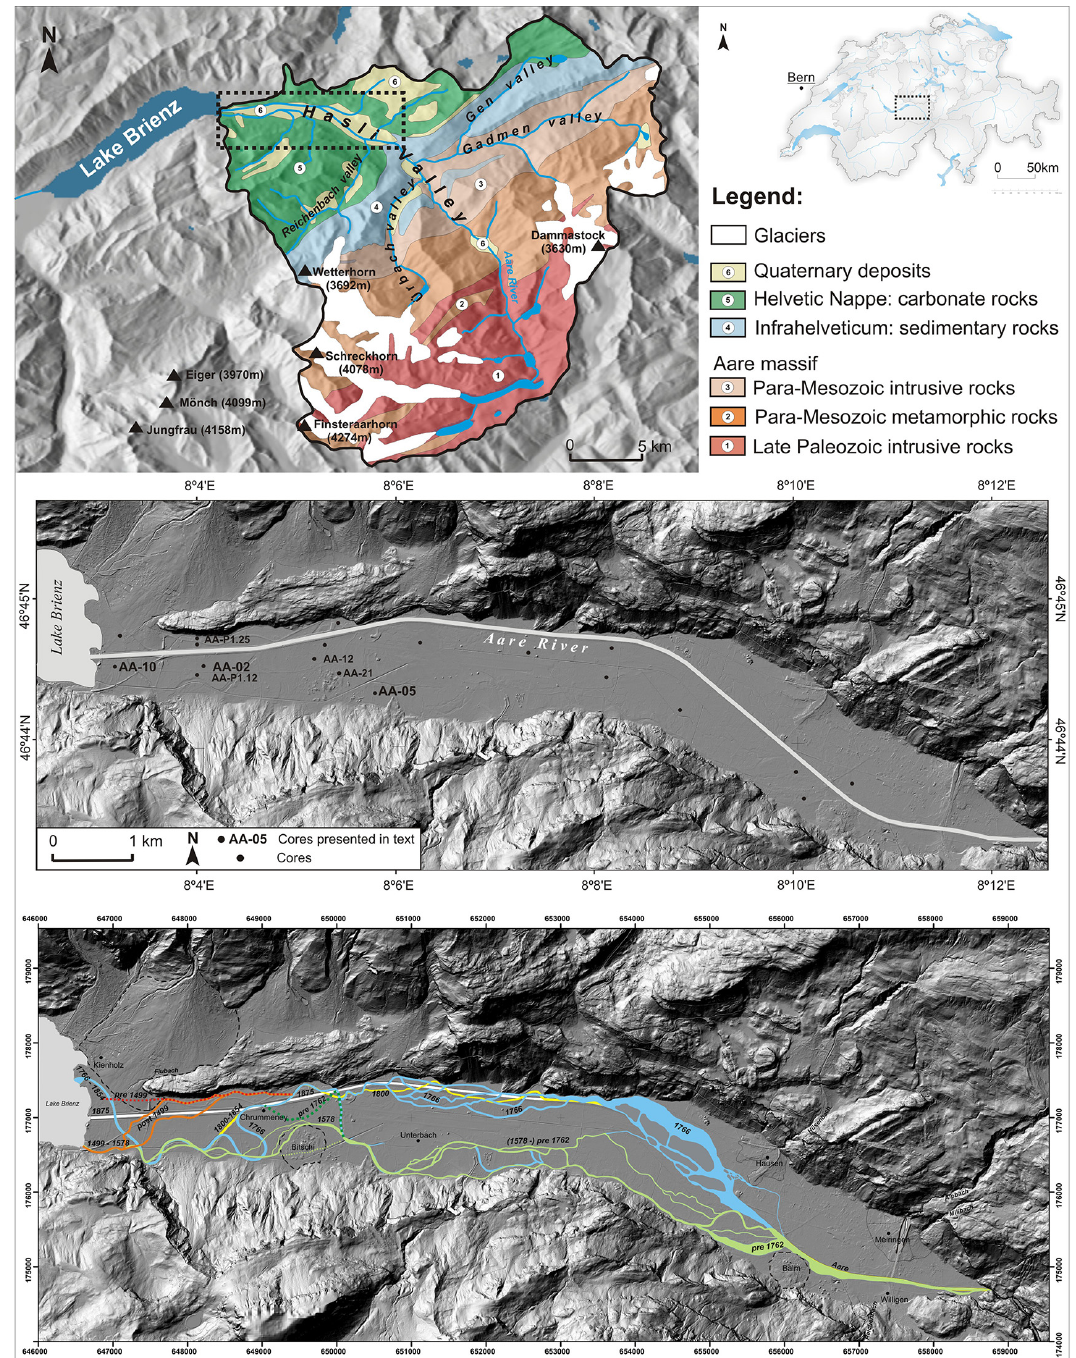
Figure 1. Geology of the Hasli–Aare catchment and digital terrain model of the Aare Delta plain in the lower Hasli Valley showing the location of retrieved cores (black dots). Labelled dots represent key cores mentioned in the text. Bottom: evolution of the Aare River palaeochannels reconstructed from historical maps, field surveys and documentary sources (this paper). Age of reconstructed channels: red discontinuous: 1251–1499; orange: post-1499; green: 1578–pre-1762; discontinuous dark green: 1551–1762; blue: 1766; yellow: 1800; white: post-Aare correction in